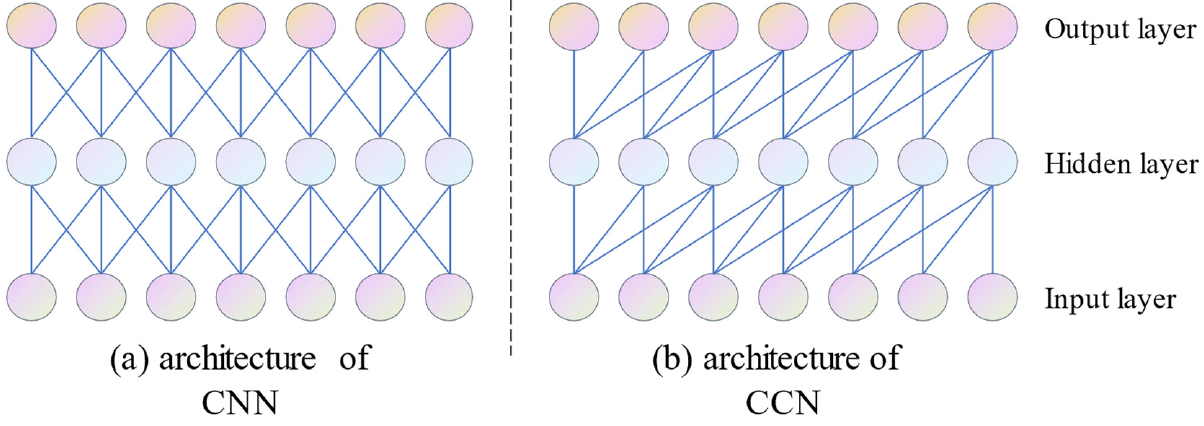
Figure 1. The typical structure of standard